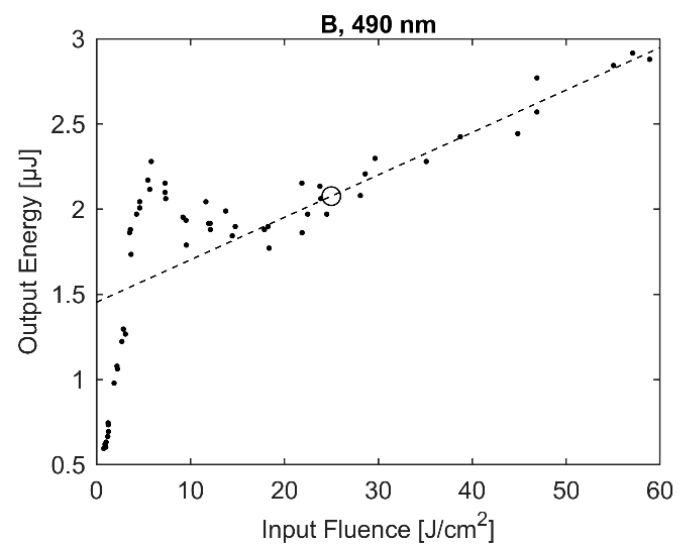
Figure 4. Representative OPL measurement for molecule “B” at 490 nm excitation wavelength. The dots are the measured data. The dashed line is the linear fit of the “cuto ff level”, and the circle is the value used for plotting, as in Figure